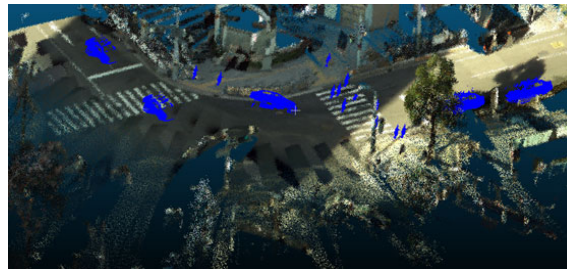
Figure 5 . Example of Temporal Changes.